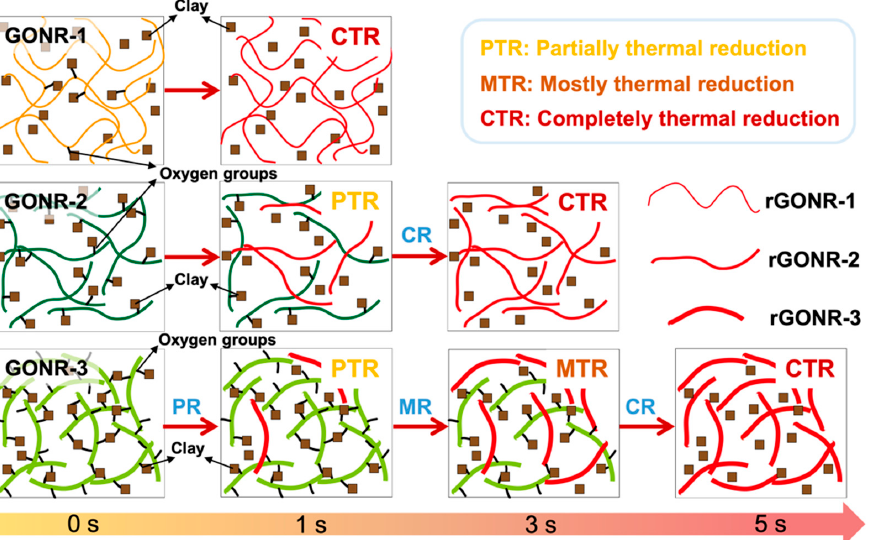
Figure 7. Schematic illustration of fire-warning mechanisms of nanocomposite papers with different oxidation degrees of GONRs under high-temperature conditions.